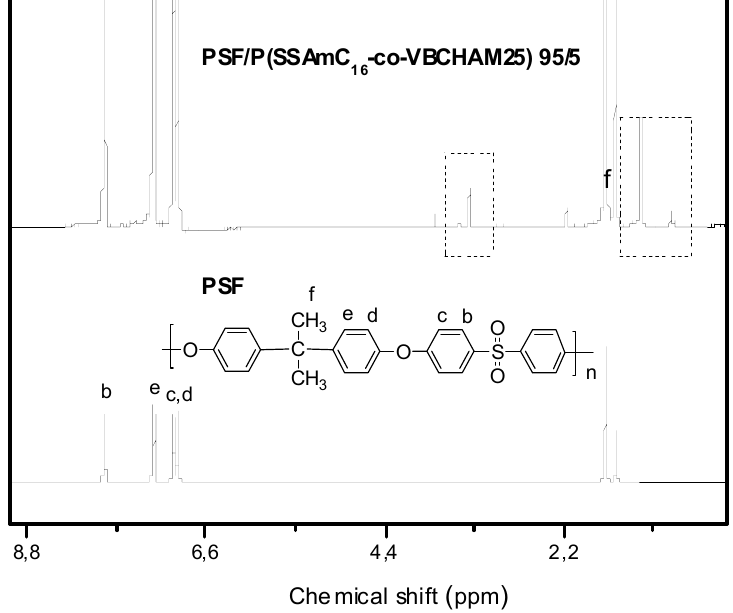
Figure 5. 1 H-NMR spectra of neat PSF, and the membrane PSF/P(SSAmC 16 -co-VBCHAM25) at composition 95/5 (%wt).